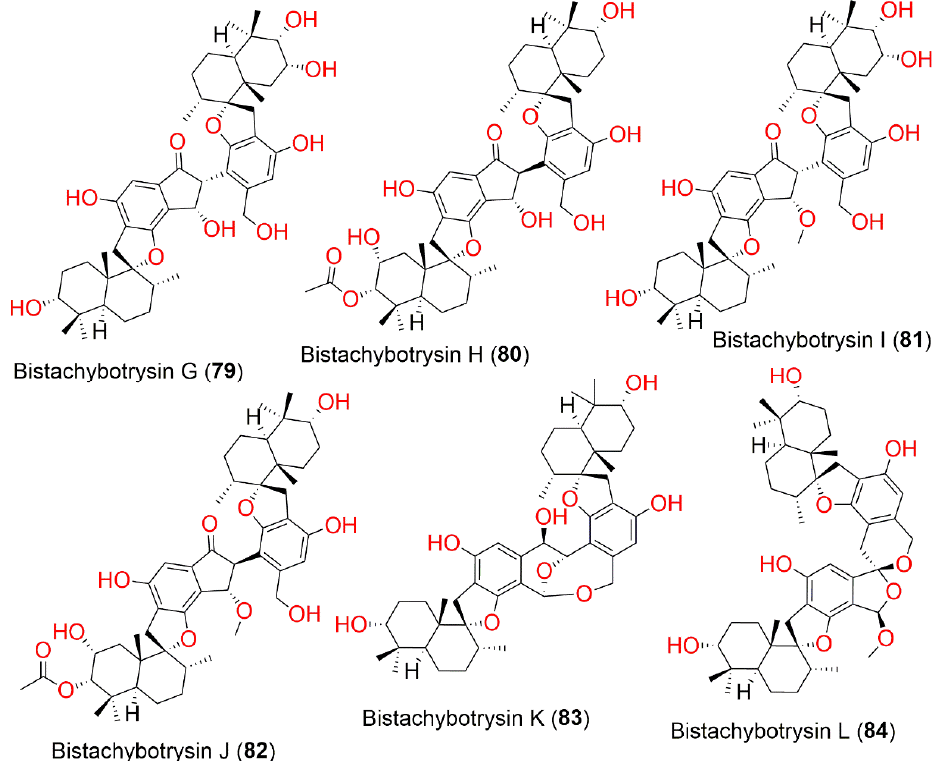
Figure 9. Structures of dimeric phenylspirodrimane derivatives ( 79 – 84 ) reported from S . chartarum